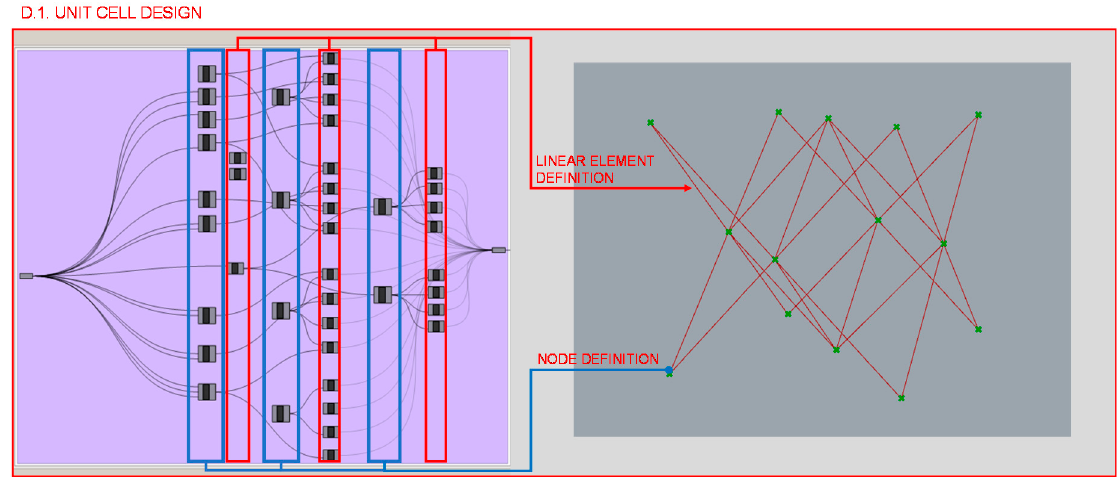
Figure 25. Programming structure definition of the infill unit cell and its visualization in the Rhinoceros interface.